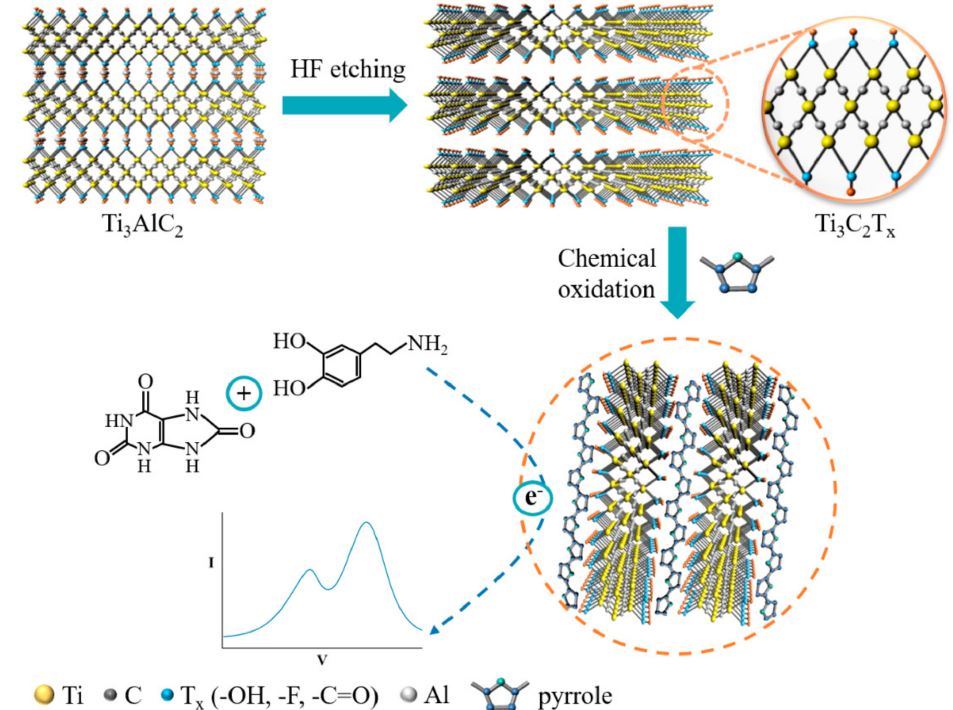
Figure 1. A schematic illustration of the synthesis of the MXene/PPy